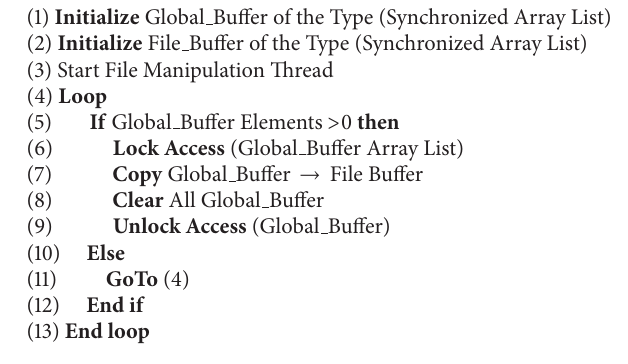
Algorithm 2: Proposed data logging thread.